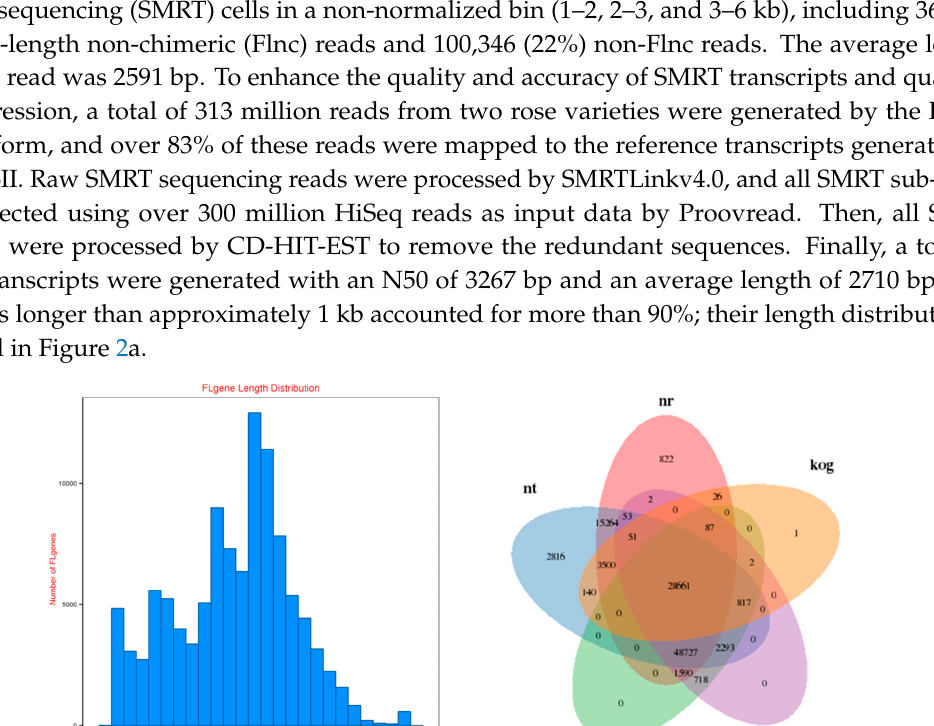
Figure 1. Petal material of Rosa ‘Margo Koster’ ( a ) and Rosa ‘White Margo Koster’ ( b ) at blooming stage used for RNA-seq ( c ) work process of bioinformatics analysis of hybrid RNA sequencing in this study. Table 1. Summary of sequencing data from PacBio platform.